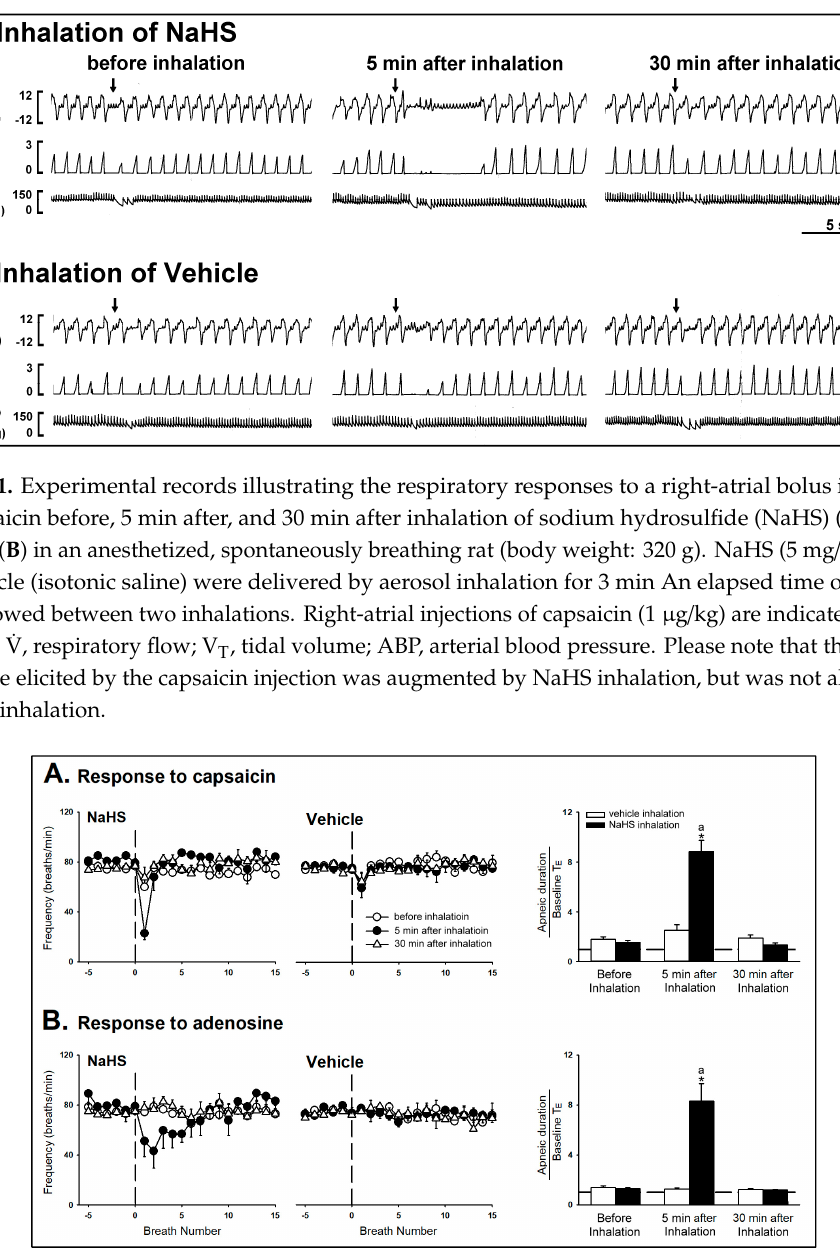
Figure 2. Effects of the inhalation of sodium hydrosulfide (NaHS) or its vehicle on the breathing frequency changes (left panel) and apneic response (right panel) to right-atrial injection of capsaicin ( A ) or adenosine ( B ) in two groups of anesthetized, spontaneously breathing rats. The apneic ratio was defined as the apneic duration occurring during 20 s after the capsaicin or adenosine injections divided by the baseline expiratory duration (T E ). Data are means ± SE for six rats. a , significantly different from before inhalation ( p < 0.05); *, significant difference when corresponding data between vehicle and NaHS inhalation were compared ( p < 0.05).